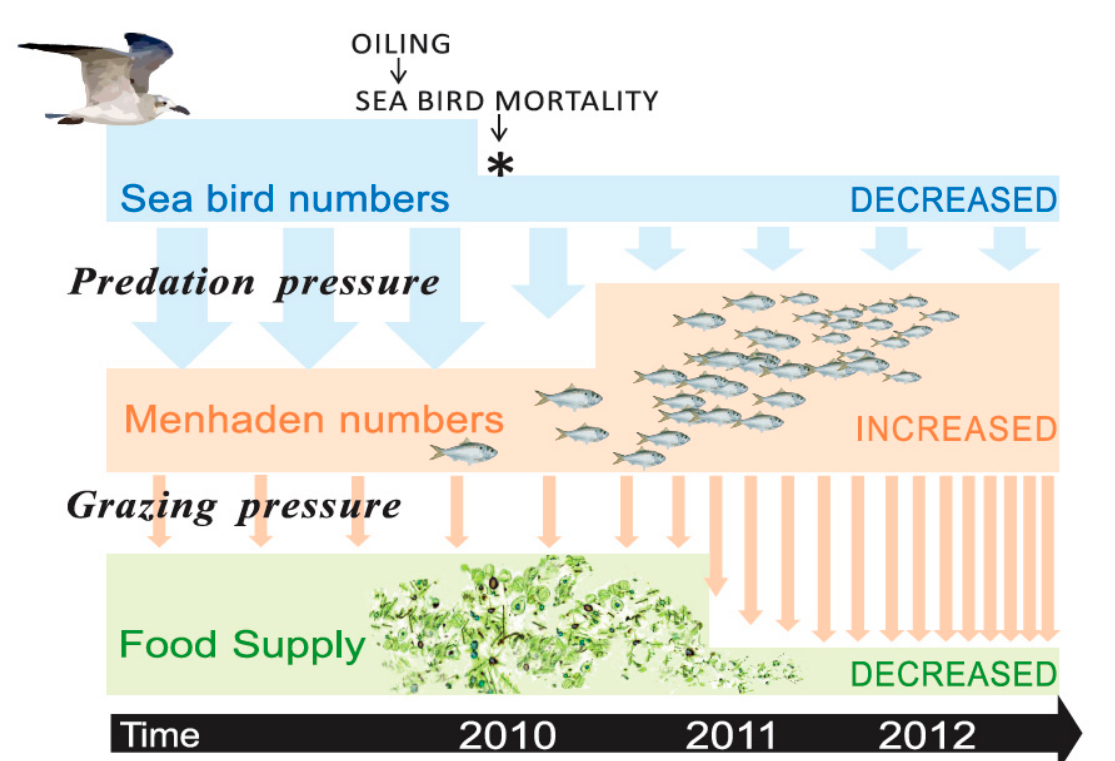
Figure 5. Depiction of proposed trophic cascade triggered in part by seabirds killed by oiling from the 2010 Deepwater Horizon blowout, increasing recruitment of juvenile Gulf menhaden through reduced predation by seabirds on them, followed by increased consumption of planktonic prey by Gulf menhaden.